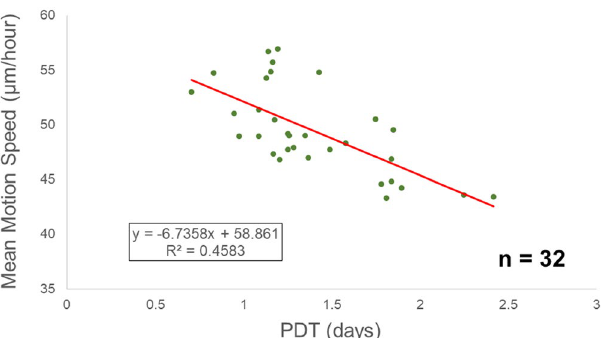
Figure 2. Correlation of the motion index of p1 oral keratinocyte cells/colonies with their proliferative capacity under standard cell culture protocol. Scatterplot showing the correlation between their MMS and proliferative capacity (PDT). The trend line is added, and its equation and the correlation coefficient are shown. (Spearman’s r = − 0.6669, p < 0.0001, n = 32